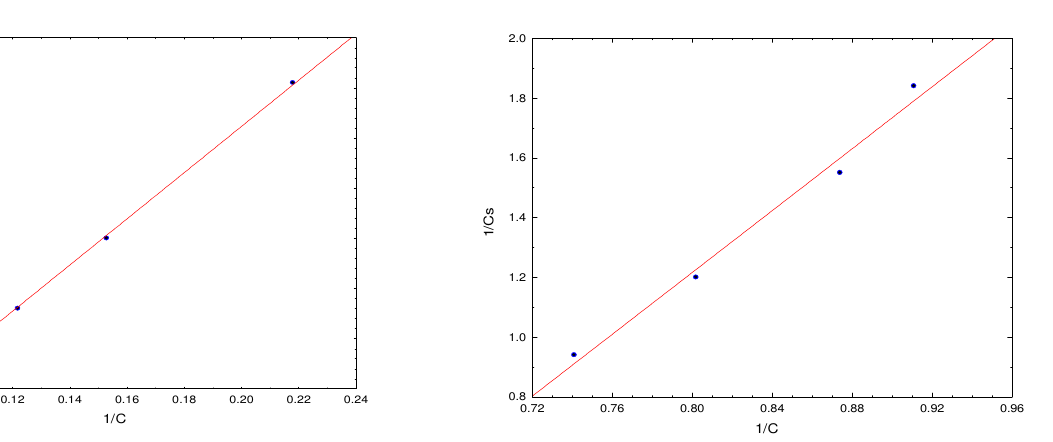
Fig. 24. plot the concentrations according to Langmuir adsorption isotherm for TOC.